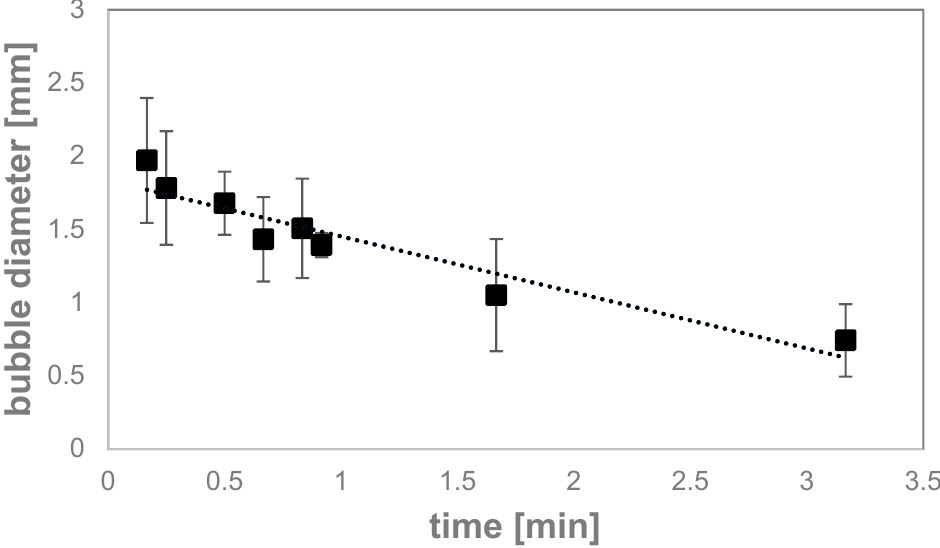
Figure 3. Equivalent diameter decrease during dissolution.